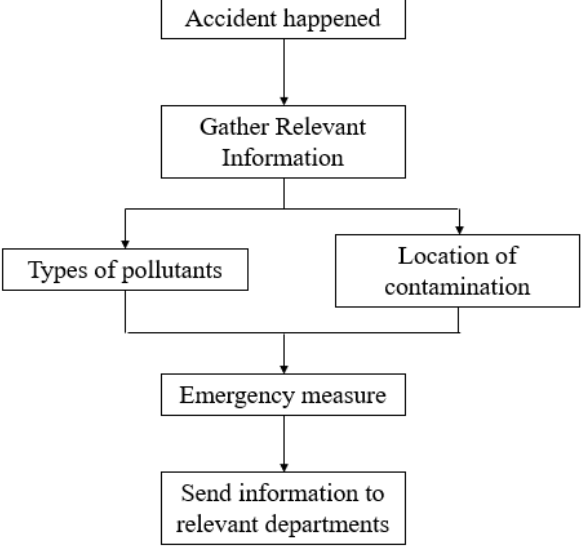
Figure 6. Flow chart of the accident warning system.